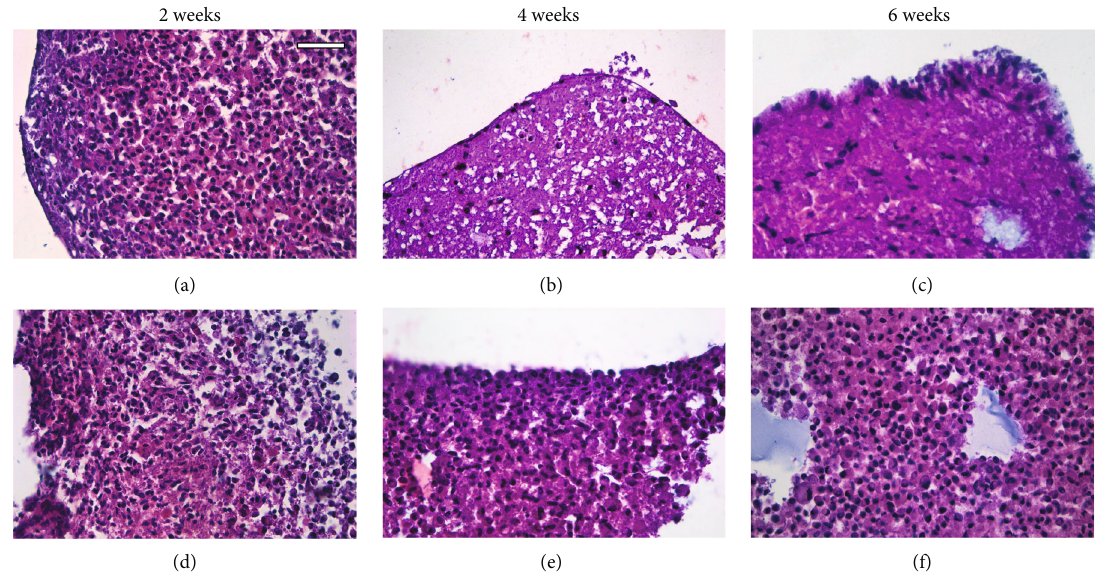
Figure 3: H-E staining images of hDPSC microtissue cultures after (a, d) 2 weeks, (b, e) 4 weeks, and (c, f) 6 weeks. Culture media used were (a – c) proliferation and (d – f) chondrogenic di ff erentiation. Scale bar = 50 μ m